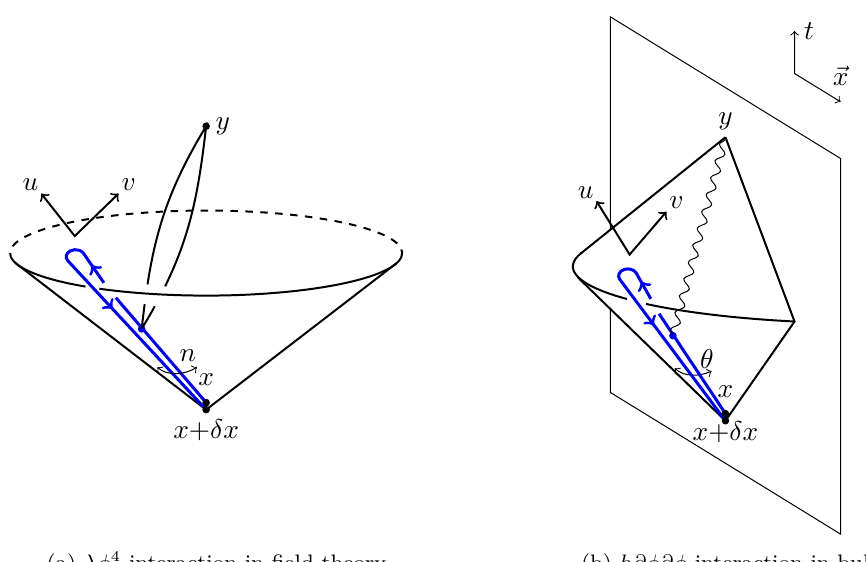
Figure 2 . Folded OPE limit of three-point functions, in perturbative field theory and in perturbative gravity. Singularities as δx → 0 come from paths which leave x on the first timefold and return nearby on the second timefold, approximately following null geodesics (thick blue lines). The two panels need not be continuously connected: boundary and bulk perturbation theory don’t normally overlap. They look technically similar because the Landau analysis applies to any perturbative description, whether it exists in the original spacetime or in a dual